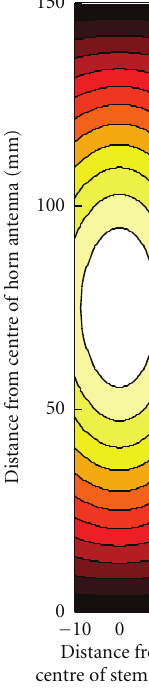
Figure 7: Temperature distribution in the longitudinal cross- section of a 10 mm thick plant stem created by a horn antenna projecting microwave energy into the stem (note: the temperature scales is in ◦